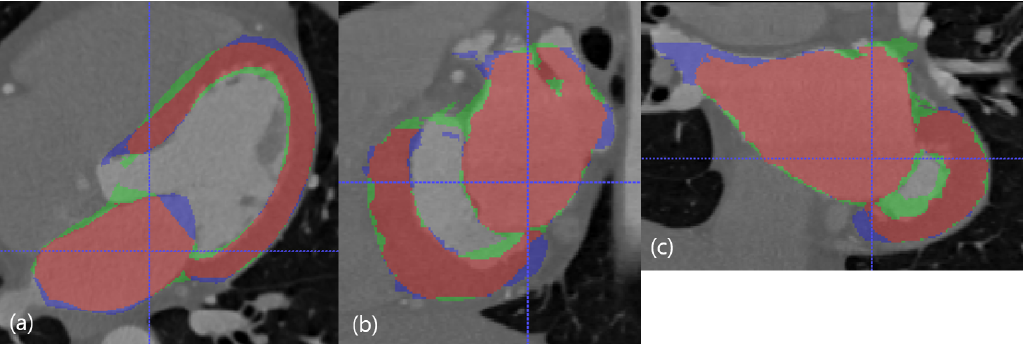
Figure 5. The best case in the dimension of DC. The red resultant mask is true positive, the blue mask is false negative, and the green resultant mask is false positive. SSD, HD, and DC are presented as the (LV SSD, LA SSD, LH SSD, LV HD, LA HD, DC) set, which is (1.79 mm, 1.74 mm, 1.77 mm, 17.74 mm, 17.78 mm, 85.95%). ( a ) Axial view. ( b ) Sagittal view. ( c ) Coronal